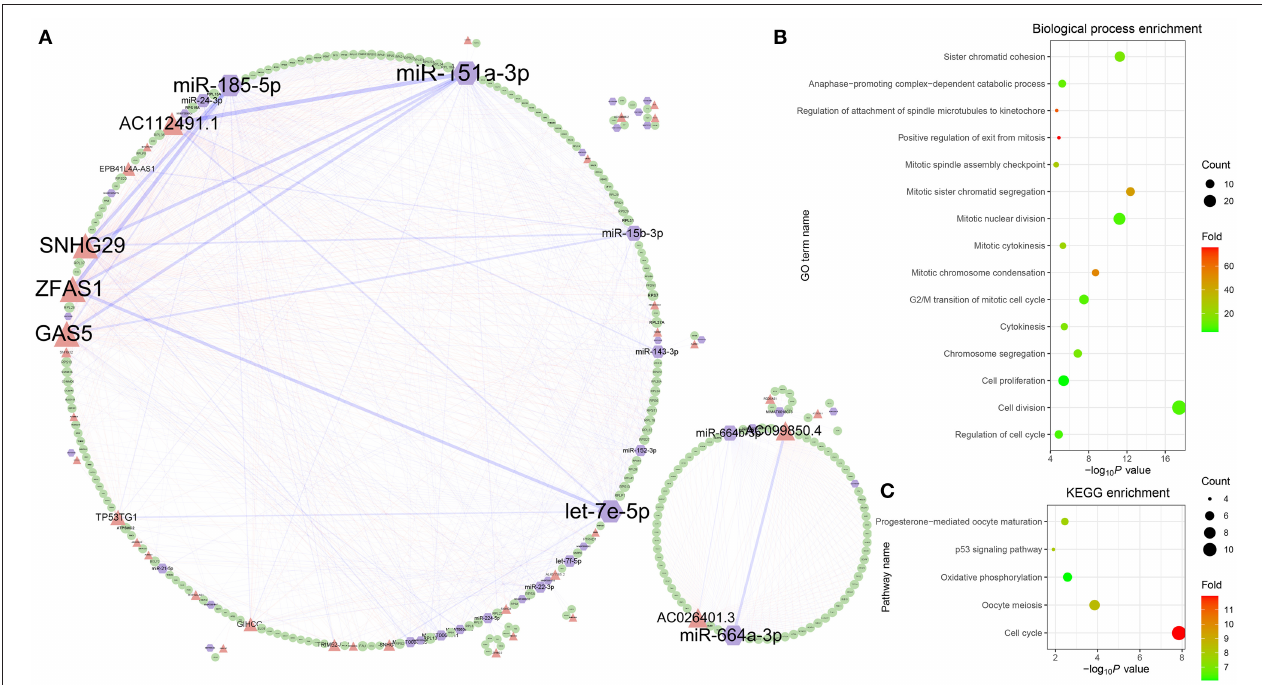
FIGURE 5 | Comprehensive analysis of the lncRNA-associated competing triplets. (A) The regulatory network consists of all the competing triplets. (B) GO biological process enrichment analysis. (C) KEGG pathway enrichment analysis.